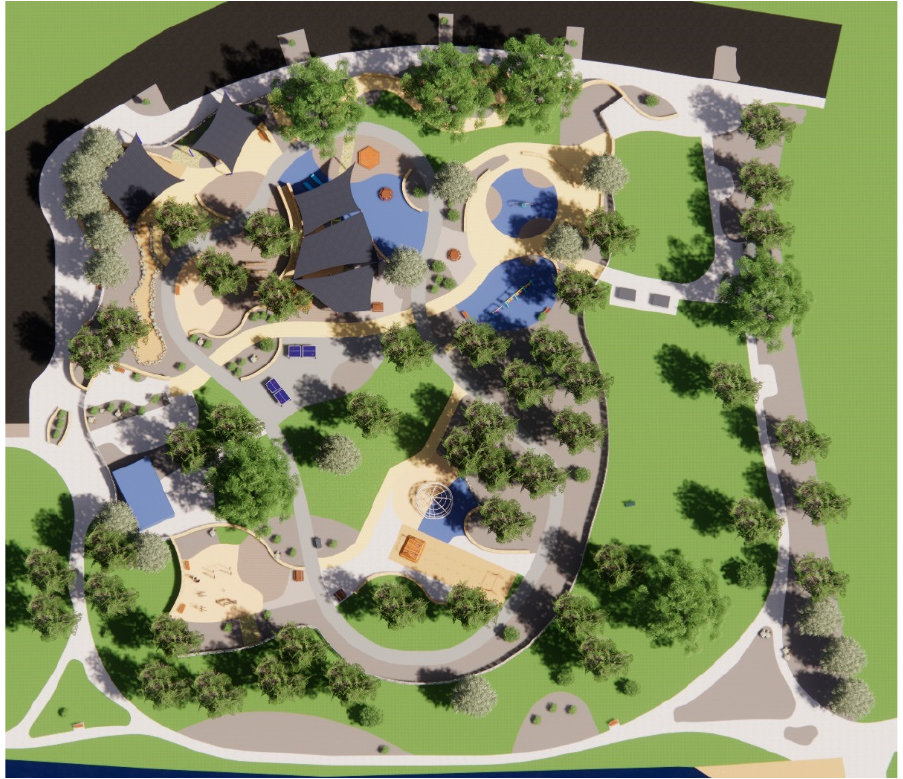
Figure 17. At 9 am on the summer solstice.